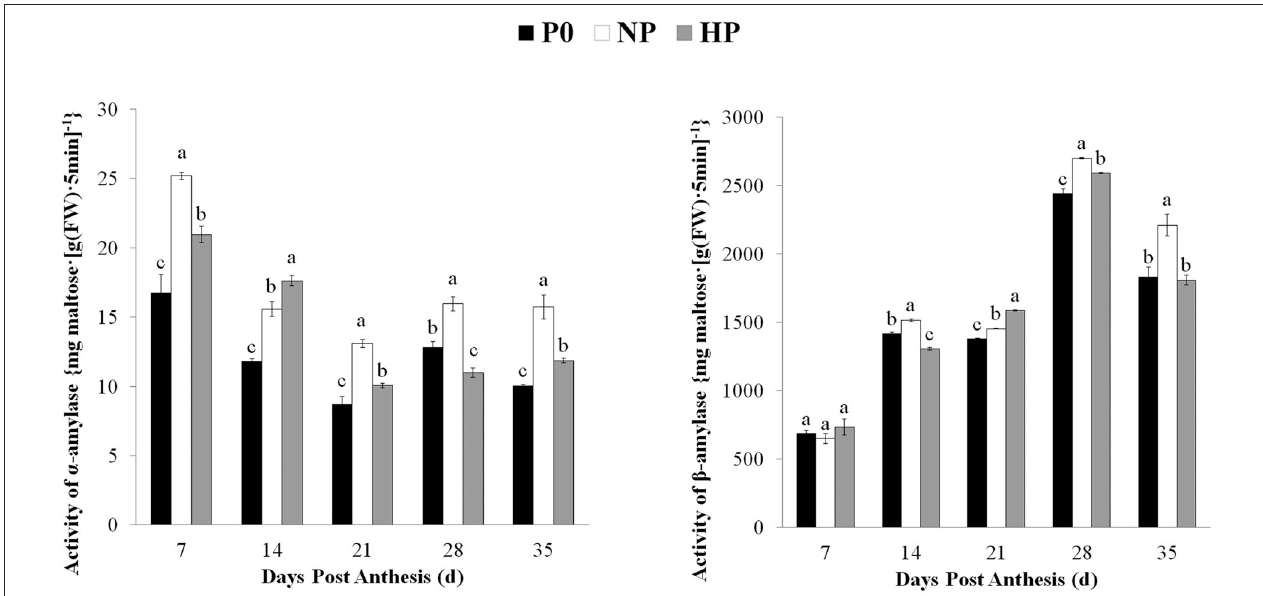
FIGURE 4 | Activities of α - and β -amylase in wheat endosperm as affected by P fertilizer application. Values are means ± S.E. of three replications. Columns with different letters are significantly different at p < 0.05. P0: 0kg P ha − 1 ; NP: 46kg P ha − 1 ; HP: 92kg P ha − 1